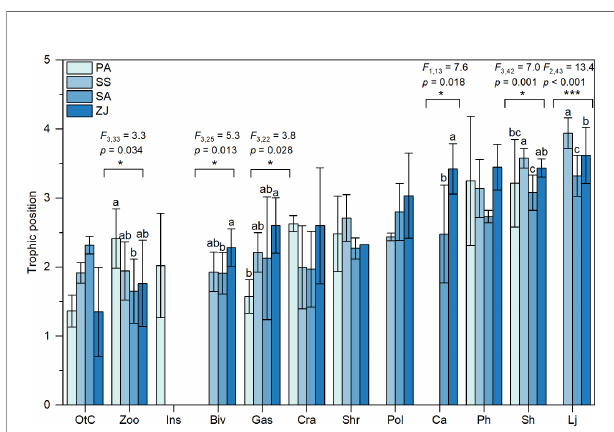
FIGURE 3 | Trophic positions (mean ± SD) identi fi ed based on the d 15 N values of consumer trophic groups collected from the Phragmites australis (PA), Suaeda salsa (SS), Spartina alterni fl ora (SA), and Zostera japonica seagrass (ZJ) habitats along the coastal topographic gradient in the Yellow River Delta wetland. Abbreviations for the trophic groups: Biv, bivalves; Ca, Carassius auratus ; Cra, crabs; Gas, gastropods; Ins, Insects; Lj, Lateolabrax japonicus ; OtC, other crustaceans; Ph, Planiliza haematocheila ; Pol, polychaetes; Sh, Synechogobius hasta ; Shr, shrimp; Zoo, zooplankton. The position of consumers on the x-axis from left to right represents an increase in the mean trophic position of the consumers across the four habitats. Signi fi cant differences in the trophic positions of the consumers among the four habitats were evaluated by one-way ANOVA (* p < 0.05; *** p < 0.001). Bars for a given trophic group that are labeled with different letters differ signi fi cantly (Tukey ’ s HSD test, p <